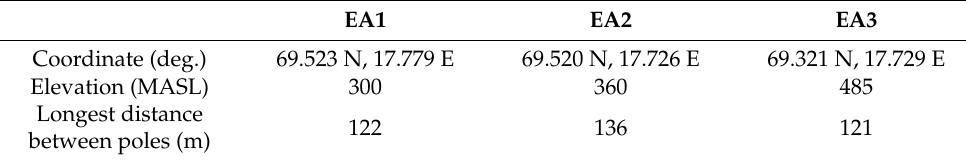
Table 1. Properties of selected weather-exposed areas in the SVAN22LY1 power